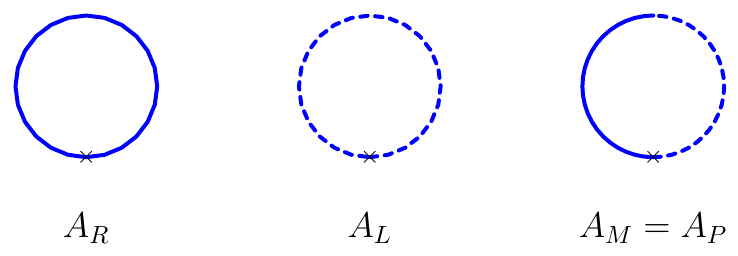
Figure 26. PV One loop A type integrals in SK